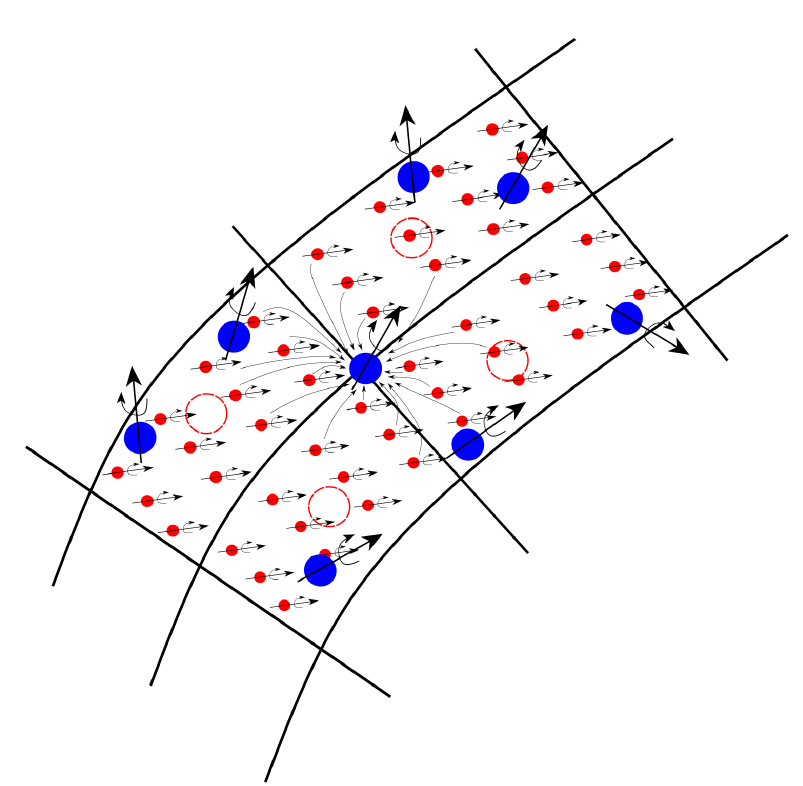
Figure 3. The Eulerian solution is used in order to correct the Lagrangian particles that are inside the Eulerian domain. Lagrangian particles are depicted as solid blue circles. Dotted red circles denote the centers of the Eulerian cells. Small solid red circles illustrate the Eulerian particles that correct the Lagrangian